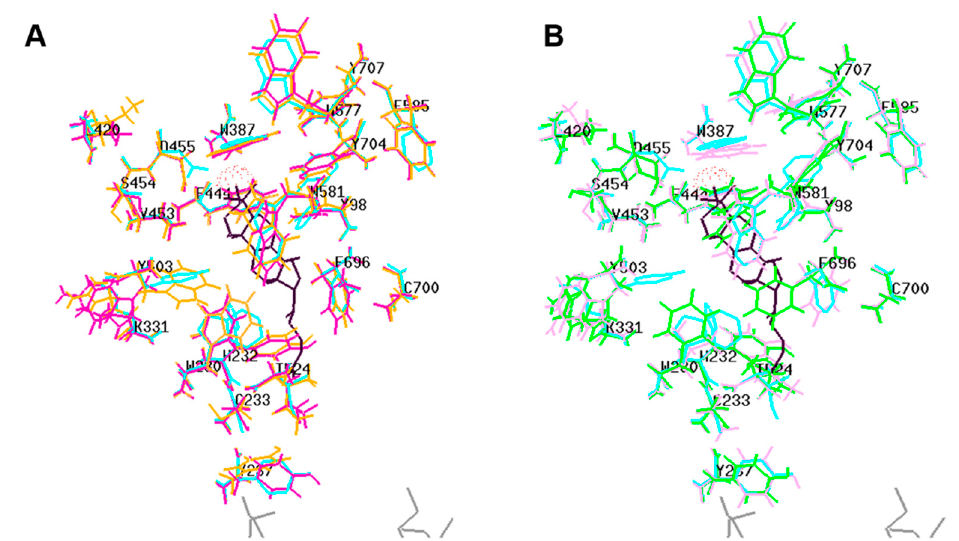
Figure 5. Critical residues of human OSC crystal structure (PDB, 1w6k) superimposed on fruit models. A: human (cyan); XP_021819911.1 (orange) and XP_021819928.1 (dark pink). B: XP_021819927.1 (light pink) and apple MdOSC1 (green). The ligand (black) is lanosterol. The red dots correspond